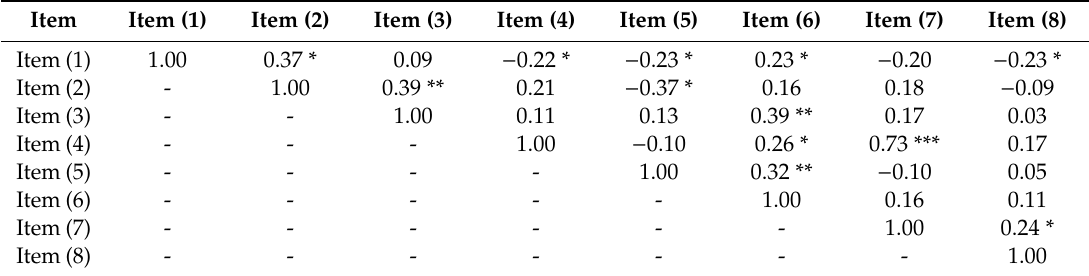
Table 3. Correlation matrix of service resources required.